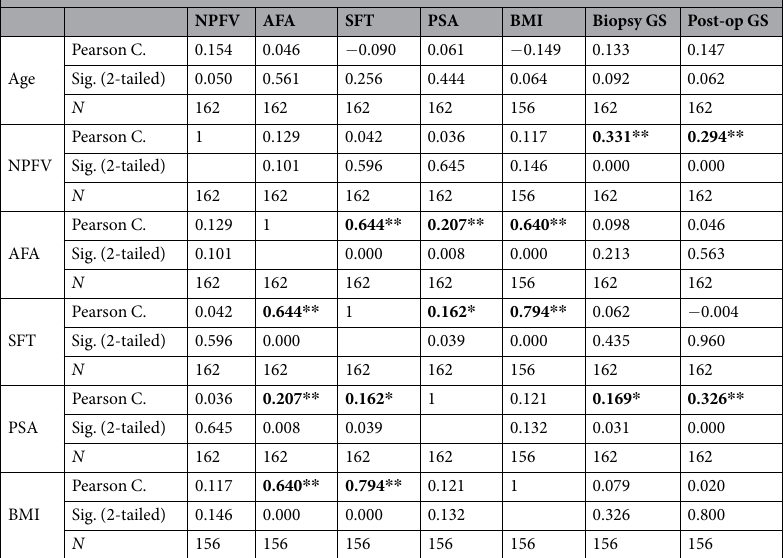
statistically significant difference between Group 2 and Group 3 ( p = 0.156). Patients with stage pT 2 had statisti- cally significantly lower NPFV (2.28 ± 0.98) than patients with stage pT 3 (2.76 ± 1.25), t(160) = − 2.760, p = 0.006.